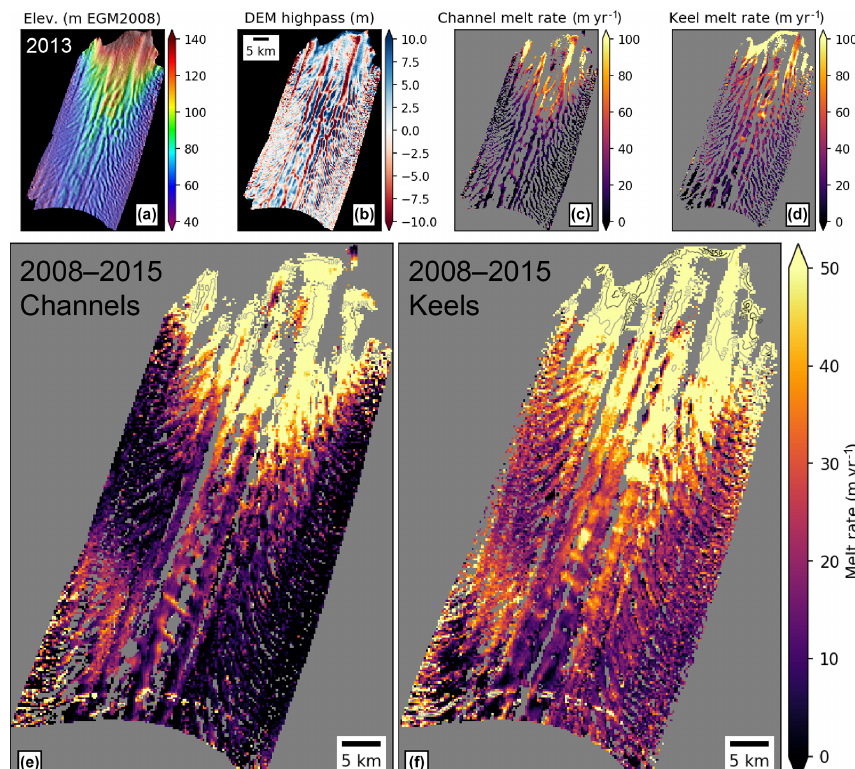
Figure 10. Relationship between kilometer-scale surface ridge (basal keel) and surface trough (basal channel) features and initial-pixel basal melt rates for main ice shelf. The top row shows example products from one 2-year period (2013–2015): (a) 256m DEM mosaic, (b) kilometer-scale surface anomalies after high-pass filter (surface ridges are blue, surface troughs are red), (c) basal melt rates for channels (where DEM anomaly is < − 1m), (d) basal melt rates for keels (where DEM anomaly is >1m). Note the relatively high basal melt rates over longitudinal basal channels at distances of ∼ 4–15km from the grounding line in (c) . The bottom row shows channel (e) and keel (f) melt- rate composites generated using all available 2-year products during the full 2008 to 2015 period. Color stretch of 0–50myr − 1 highlights differences over the outer ice shelf, where higher basal melt rates are observed on keels. See Fig. S5 for additional